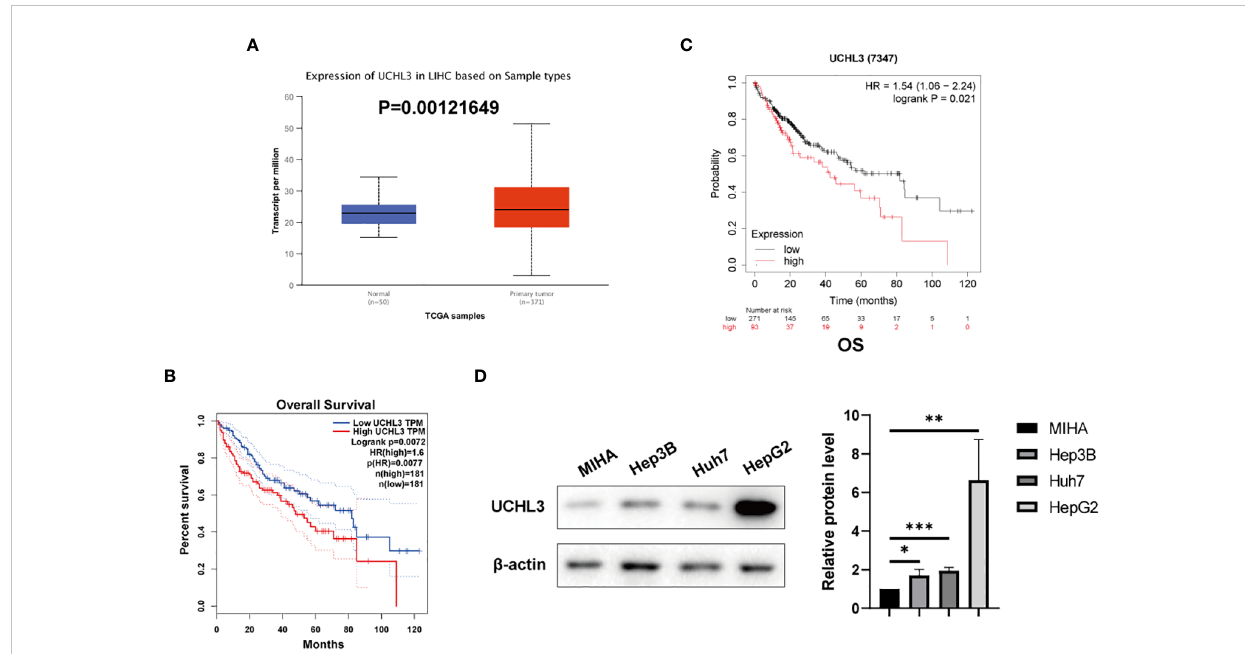
FIGURE 1 UCHL3 expression and survival analysis in HCC. (A) Data relating to primary liver tumors were downloaded from the TCGA database and analyzed by the UALCAN platform (http://ualcan.path.uab.edu/analysis.html) and showed higher UCHL3 expression in tumor tissue. (B) Kaplan – Meier analysis by the GEPIA platform (http://gepia.cancer-pku.cn) indicated that HCC patients with increased UCHL3 levels had poorer overall survival. (C) Kaplan – Meier analysis (https://kmplot.com/analysis/) of OS showed high UCHL3 expression to be associated with lower patient survival. (D) Western blots showed higher UCHL3 expression in HCC cells, Hep3B, Huh7, and HepG2, than in the normal hepatocyte cell line, MIHA. *p < 0.05, **p < 0.01, ***p <